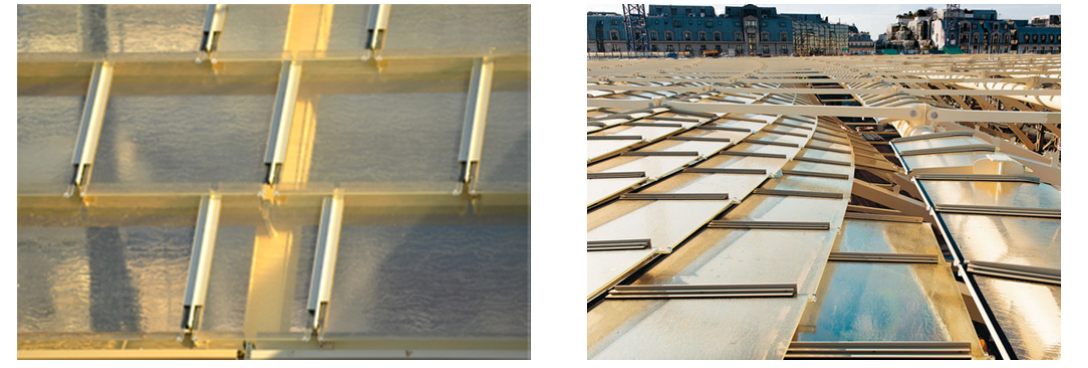
Fig. 2 Canopée Paris – Glazing detail